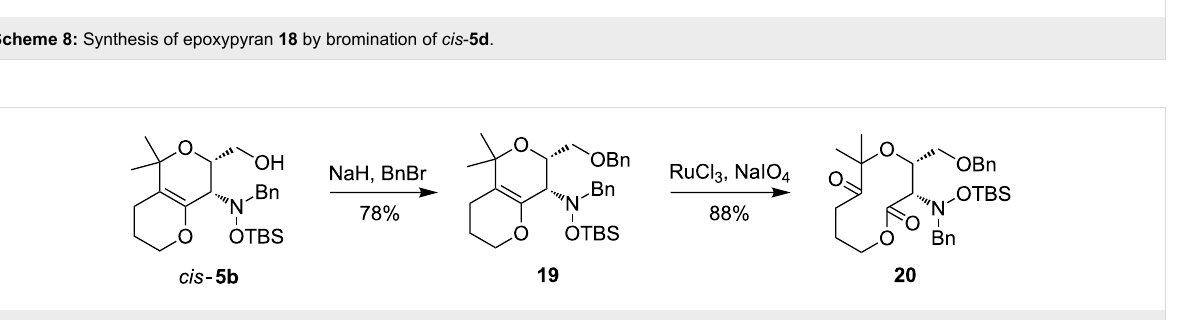
Scheme 9: Oxidative cleavage of dihydropyran 19 to lactone 20